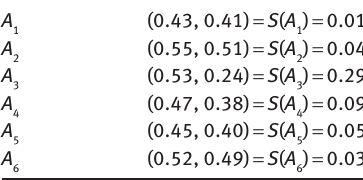
Table 5: Aggregated and Ranking Result.